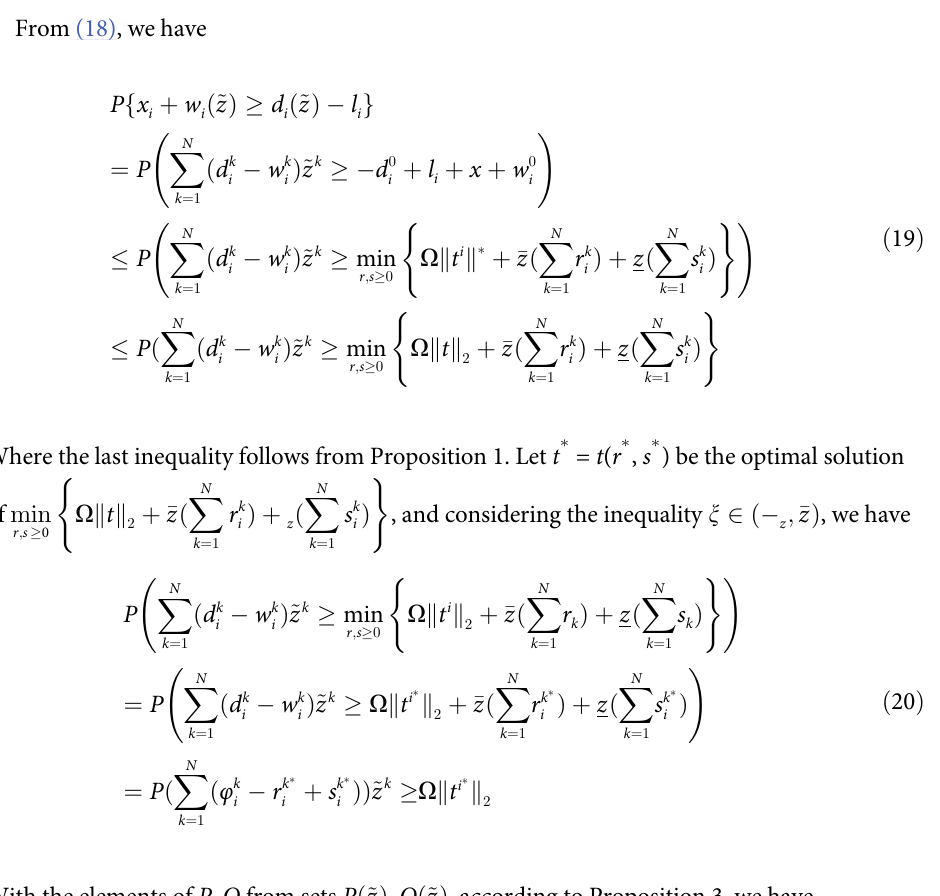
ffiffiffiffiffiffiffiffiffiffiffiffiffiffiffiffiffiffi 2 ln ð 1 = b Þ